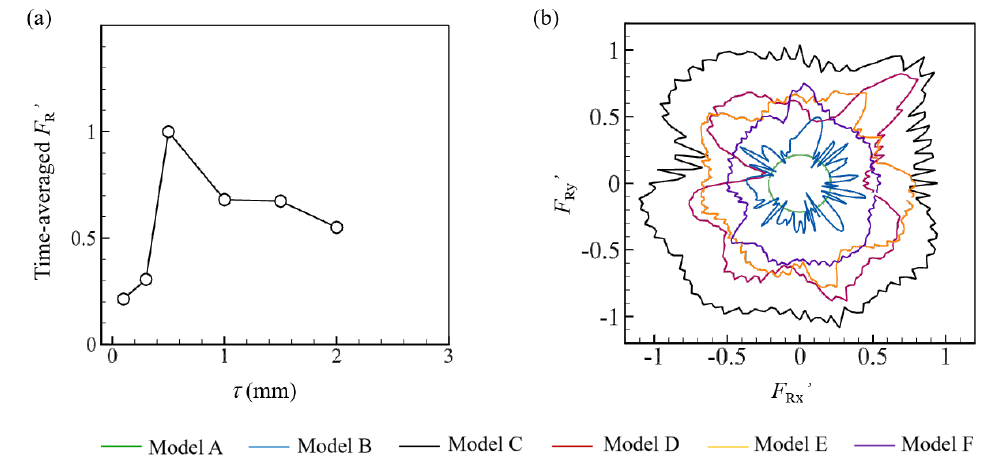
Figure 13. Normalized radial force for all six models as: ( a ) time-averaged magnitude; ( b ) or- bital